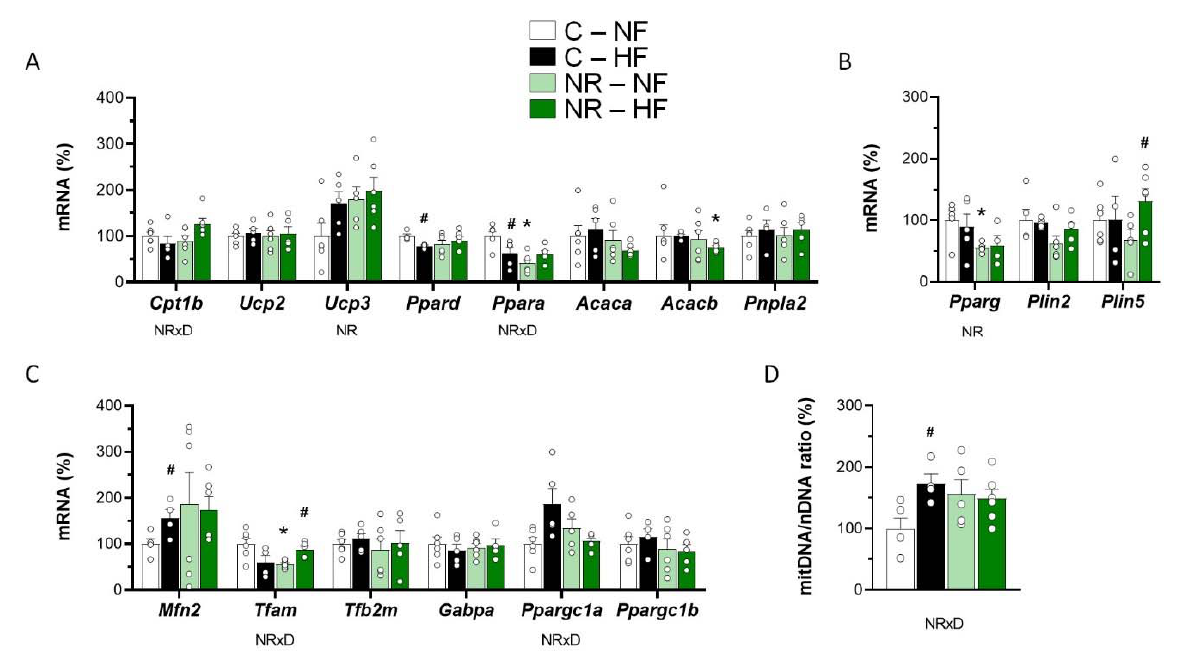
Figure 2. Early-life nicotinamide riboside (NR) treatment impacted lipid metabolism and mitochon- dria pathways in skeletal muscle in adulthood. Newborn male mice received NR or vehicle (water; control) from day 2 to 20 of age, were weaned onto a chow diet on day 21, and were assigned to either an HF or a normal-fat (NF) diet on day 90 for 10 weeks. mRNA levels of the indicated genes related to fatty acid oxidation/lipolysis ( A ), lipogenesis/lipid droplet ( B ), and mitochondria biogenesis and function ( C ) were analyzed in Gastrocnemius skeletal muscle at the end of the experiment. The mitochondrial DNA to nuclear DNA ratio of the same animals as an indicator of mitochondrial content is shown in ( D ). Data are the mean ± SEM of 5–6 animals per group and are expressed relative to the mean value of the NF-control group, which was set to 100. Circles correspond to individual data. Statistics ( p < 0.05): NR treatment, and NRxD treatment per diet interaction (two-way ANOVA); * NR vs. control, # HF vs. NF ( t -Student).